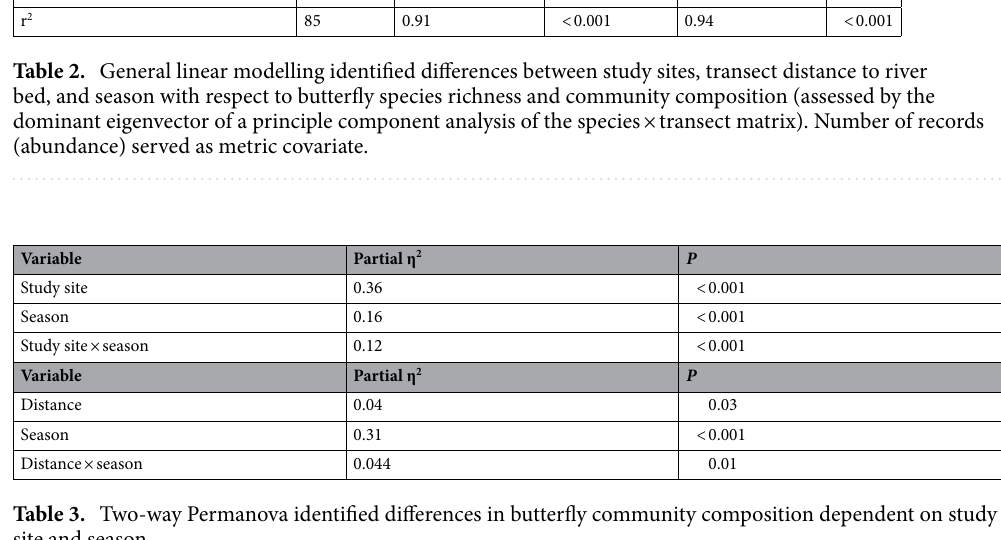
Table 3. Two-way Permanova identified differences in butterfly community composition dependent on study site and season.